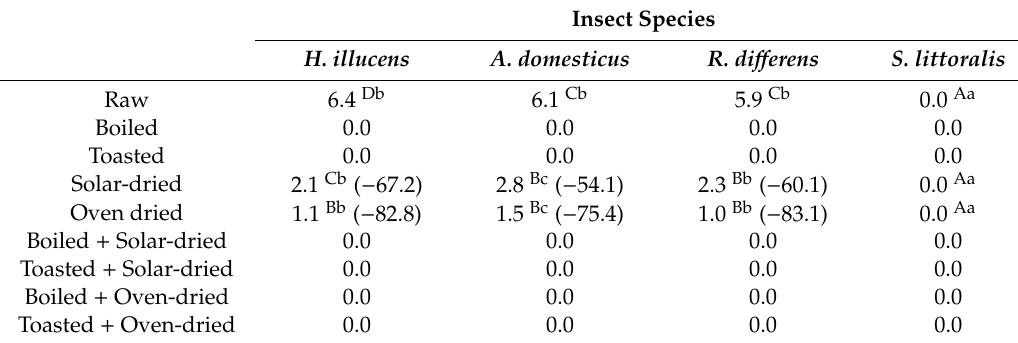
Table 4. Counts of Lac + enteric bacteria (Log colony-forming units (CFU) / g) on the raw insects and the processed